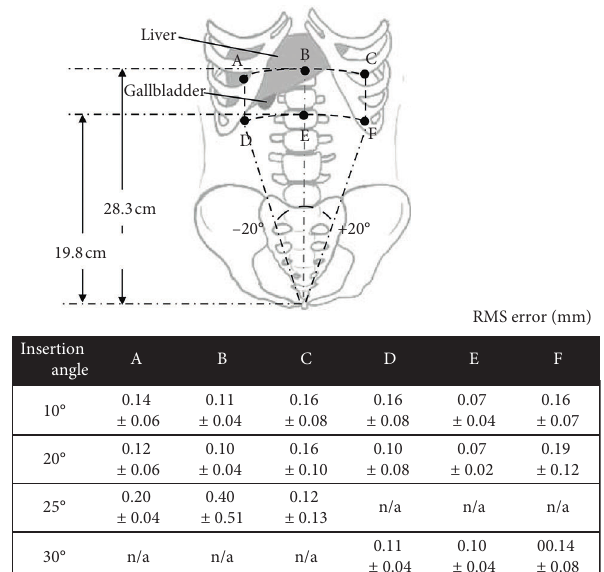
Figure 8: Reachability with measured RMS error at multiple cannula insertion angles with a maximum insertion angle of 25 ° for distal points A, B, C, and 30 ° for proximal points D, E, F).